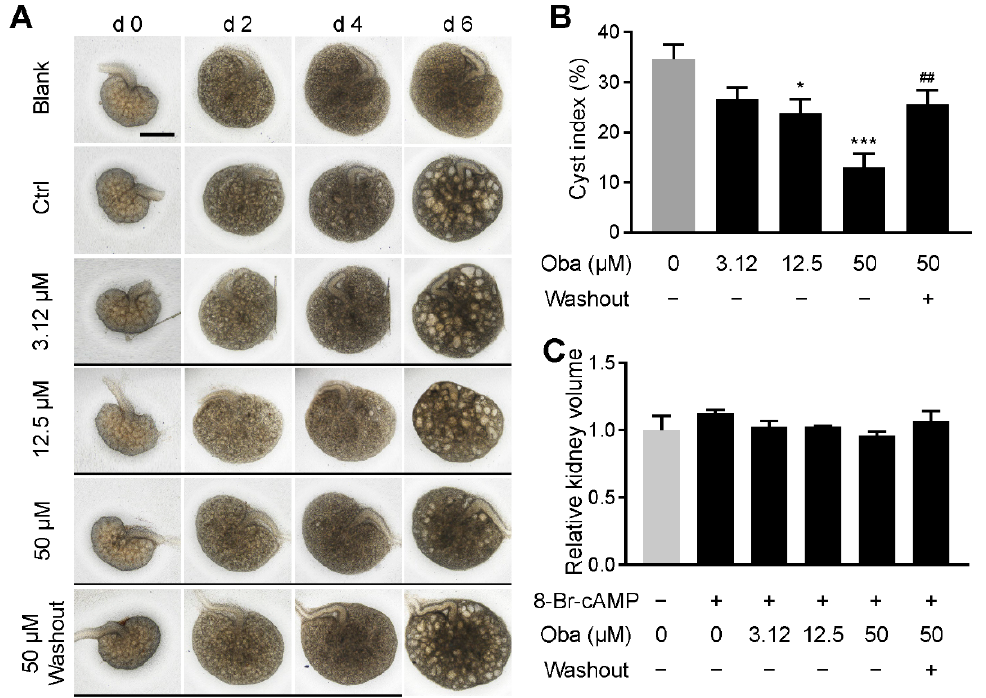
Figure 3. Inhibitory effect of obacunone on the enlargement of embryonic kidney cyst. ( A ) Representative images of embryonic kidneys treated without (Ctrl) or with obacunone. Narrow black lines indicate obacunone treatment. Bar = 500 μ m. ( B ) Cyst indices (cyst area to embryonic kidney area). ( C ) Relative kidney volumes of embryonic kidneys on day 6. Data are presented as means ± SEM. n = 6. * p < 0.05, *** p < 0.001 versus Ctrl. ## p < 0.01 versus 50 μ M obacunone treatment.